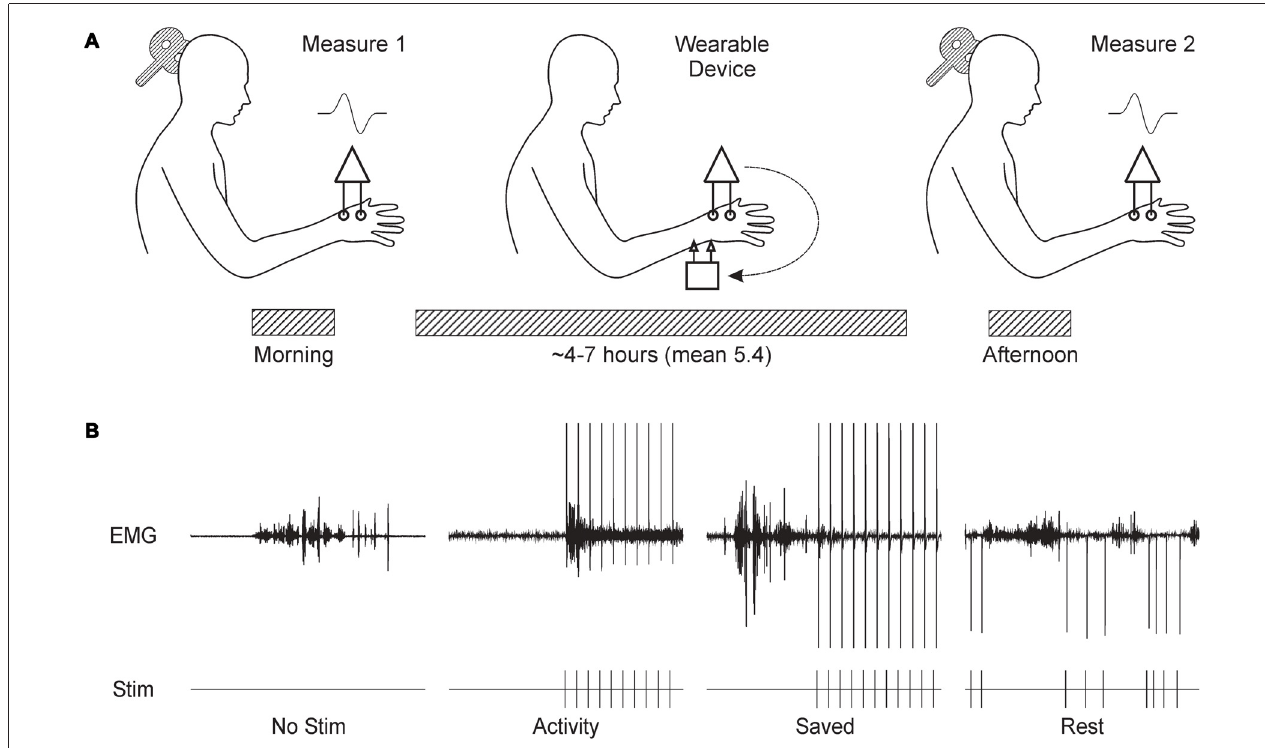
FIGURE 1 | Overview of experimental design. (A) Subjects visited the laboratory in the morning, and the recruitment curve for motor evoked potentials (MEPs) from the thenar muscles following transcranial magnetic brain stimulation (TMS) over contralateral motor cortex (M1) was recorded. Subjects were fitted with the wearable electronic device, which delivered stimulation to the median nerve at the wrist whilst recording thenar electromyogram (EMG). The subject then left the laboratory, and carried out usual daily activities. Around 6 h later, the subject returned to the laboratory for a repeat measurement of the MEP recruitment curve. (B) Illustration of the stimulus protocols tested. Each panel shows a brief section of EMG recordings made by the wearable device above markers indicating the times of stimulus delivery. No Stim , no stimuli were given. Activity , stimuli were given when smoothed rectified EMG rose above a threshold level. Saved , stimulus timing was determined from a previous Activity protocol in the same subject. Rest , stimuli were delivered after EMG had been below a threshold level for 300